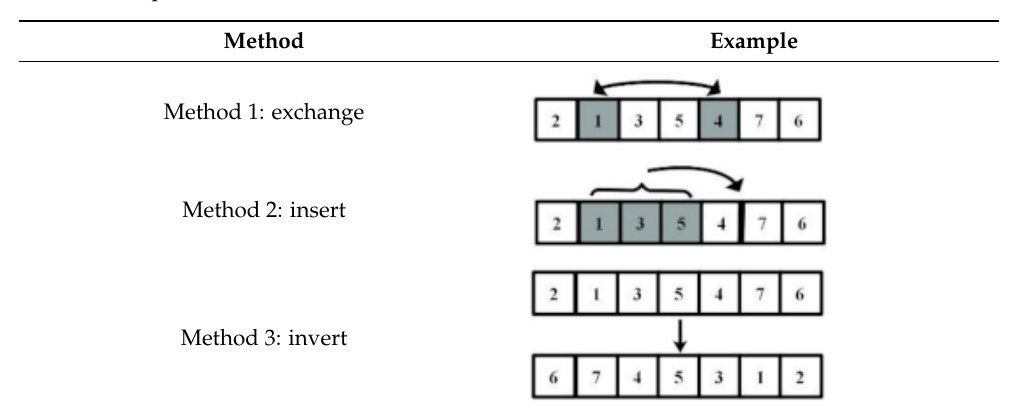
Table 2. Comparison of the three mutation